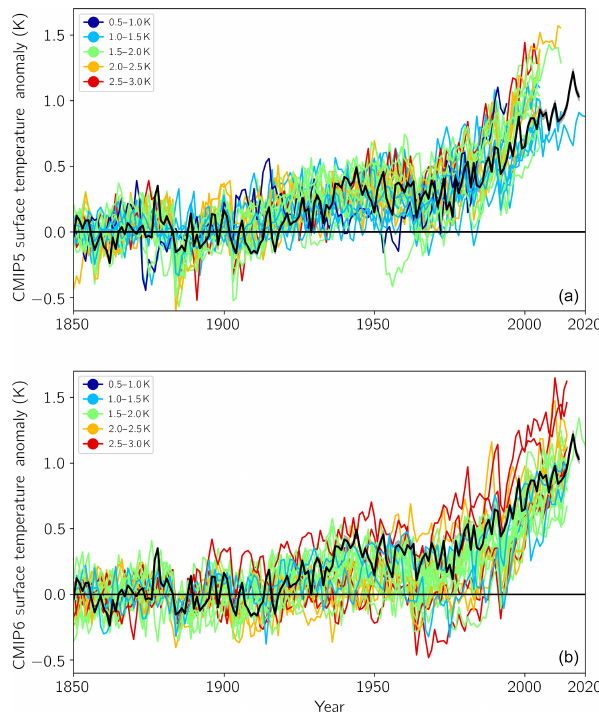
Figure 13. As in Fig. 12 but for individual model runs. Panel (a) shows CMIP5 models, and panel (b) shows CMIP6 mod- els. Color coding is according to the respective models’